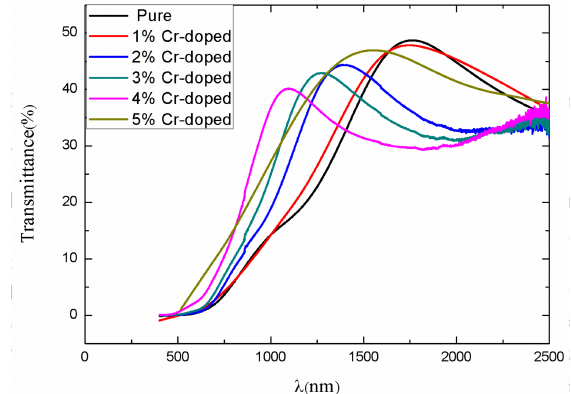
Figure 4. The optical transmittance spectra of the pure and Cr-doped PbS thin films.